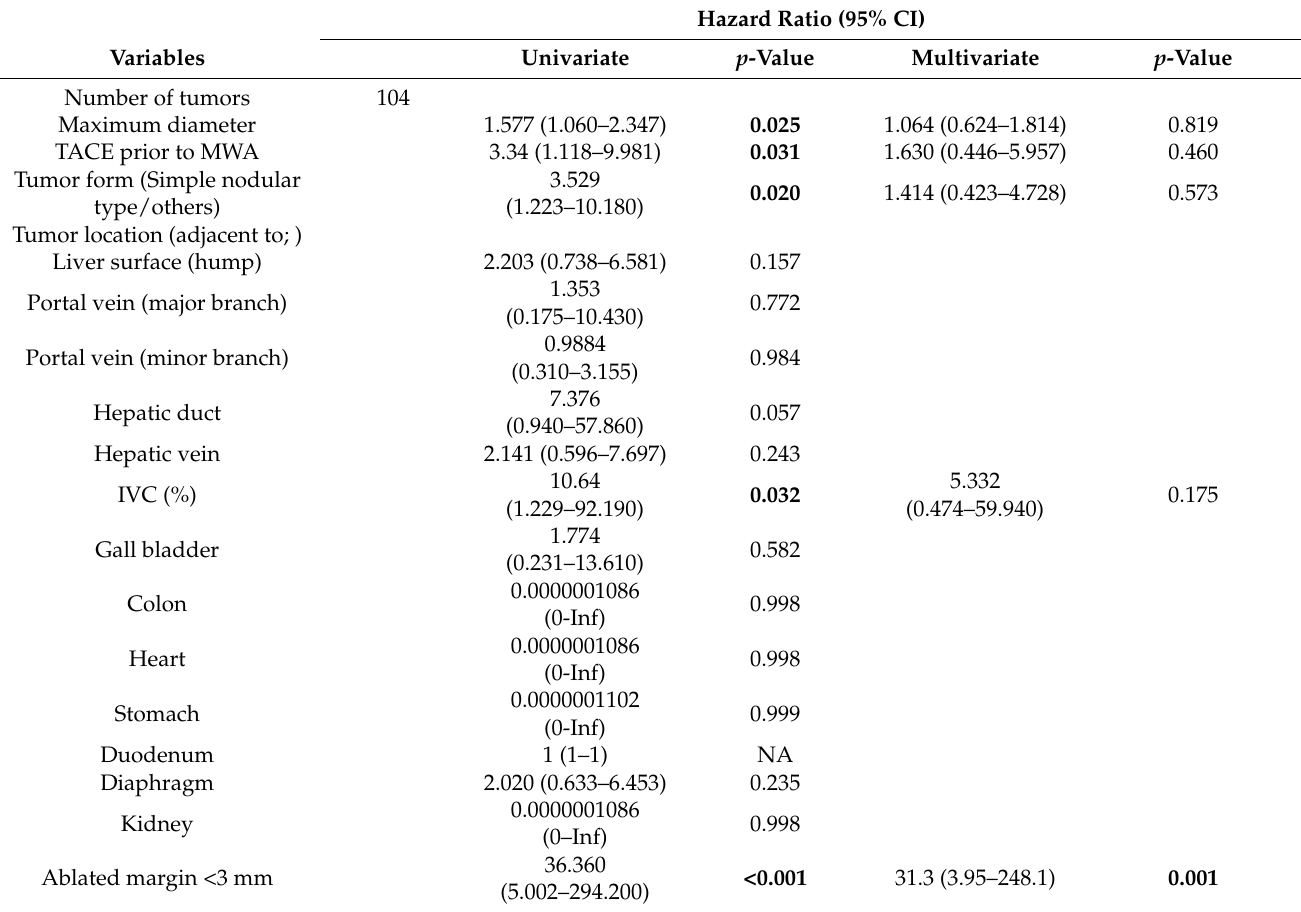
Table 5. Predisposing factors for local tumor progression after